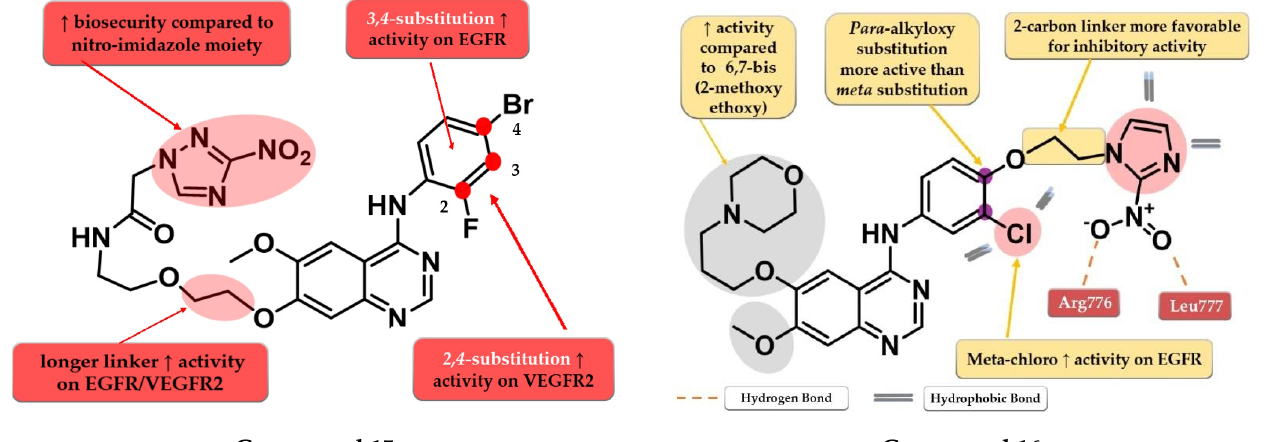
Figure 10. Structure–activity relationship and molecular docking of compound 15 in the active site of EGFR as reported by Wei et al. [120]; structure–activity relationship and molecular docking of compound 16 in the human EGFR kinase domain (PDB ID 1XKK) [101], as reported by Cheng et al. [121].